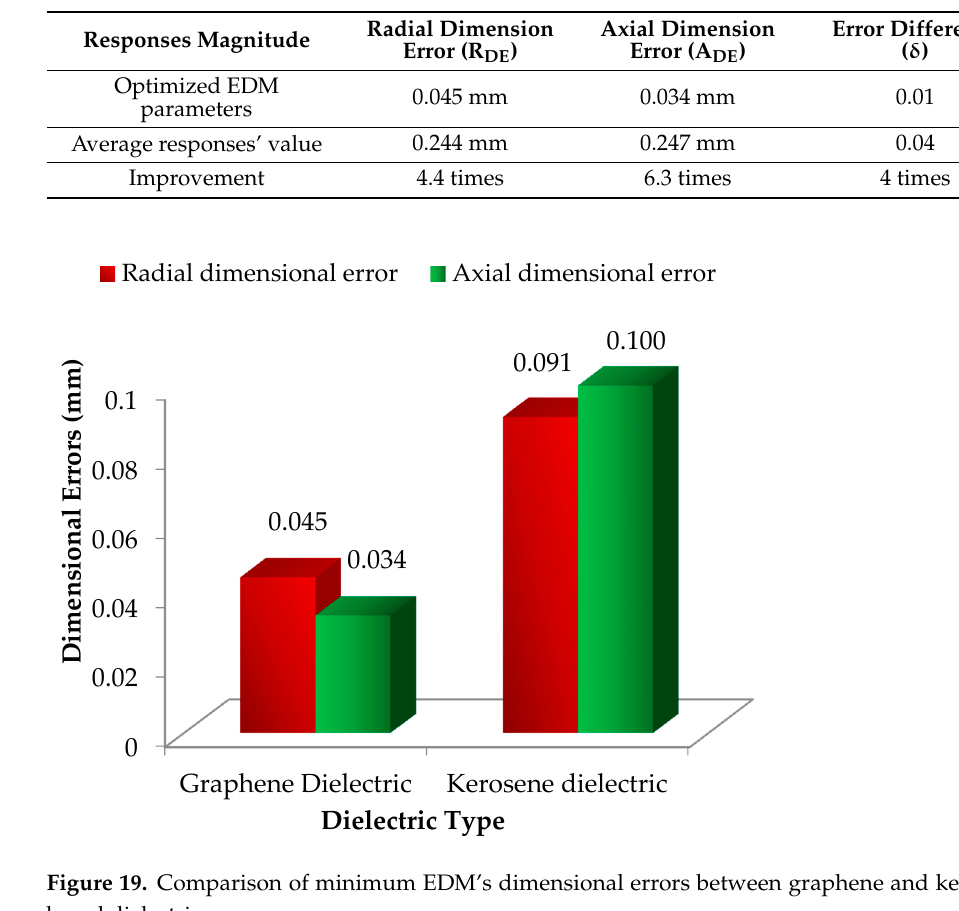
Table 7. Confirmatory experimental results obtained by implementing optimized EDM’s input parameters.